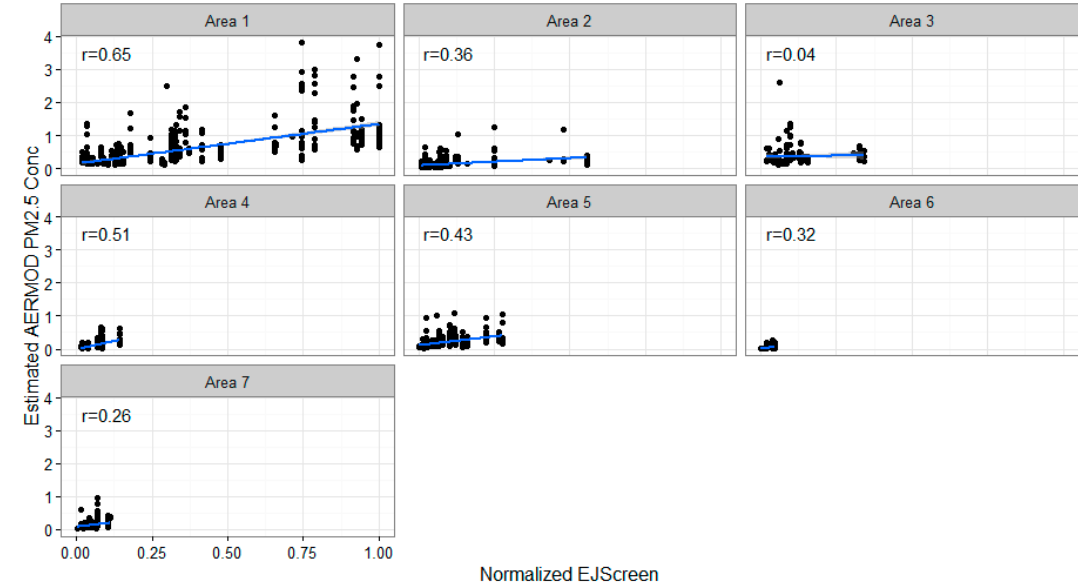
Figure 2. Particulate matter (PM 2.5 ) and normalized EJScreen index values.